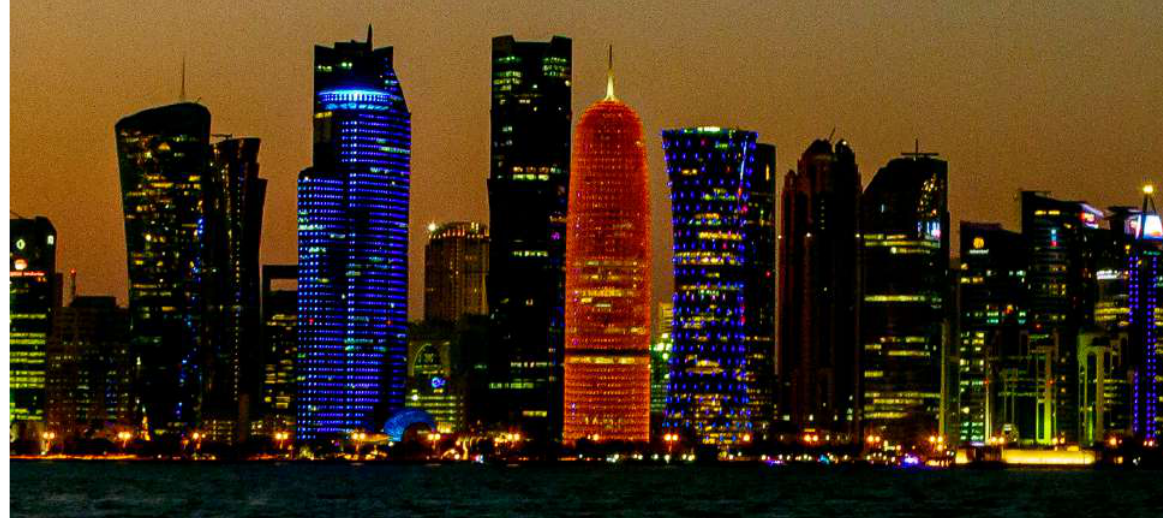
Fig. 1 West Bay skyline at night: Burj Qatar in the centre illuminated in red (Source: Arendt Kuester,